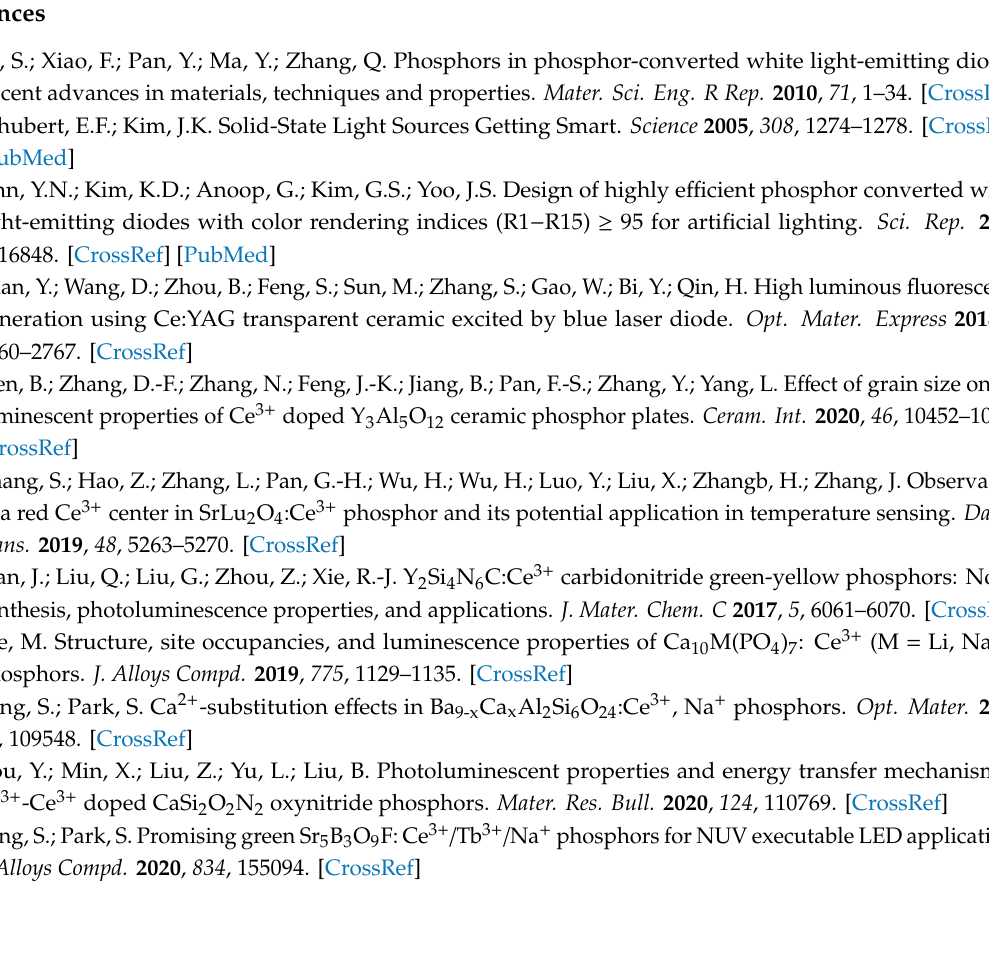
Figure S1: The integrated emission intensities of La 0.95 Eu 0.05 O 0.65 F 1.7 and La 0.94 Bi 0.05 O 0.65 F 1.7